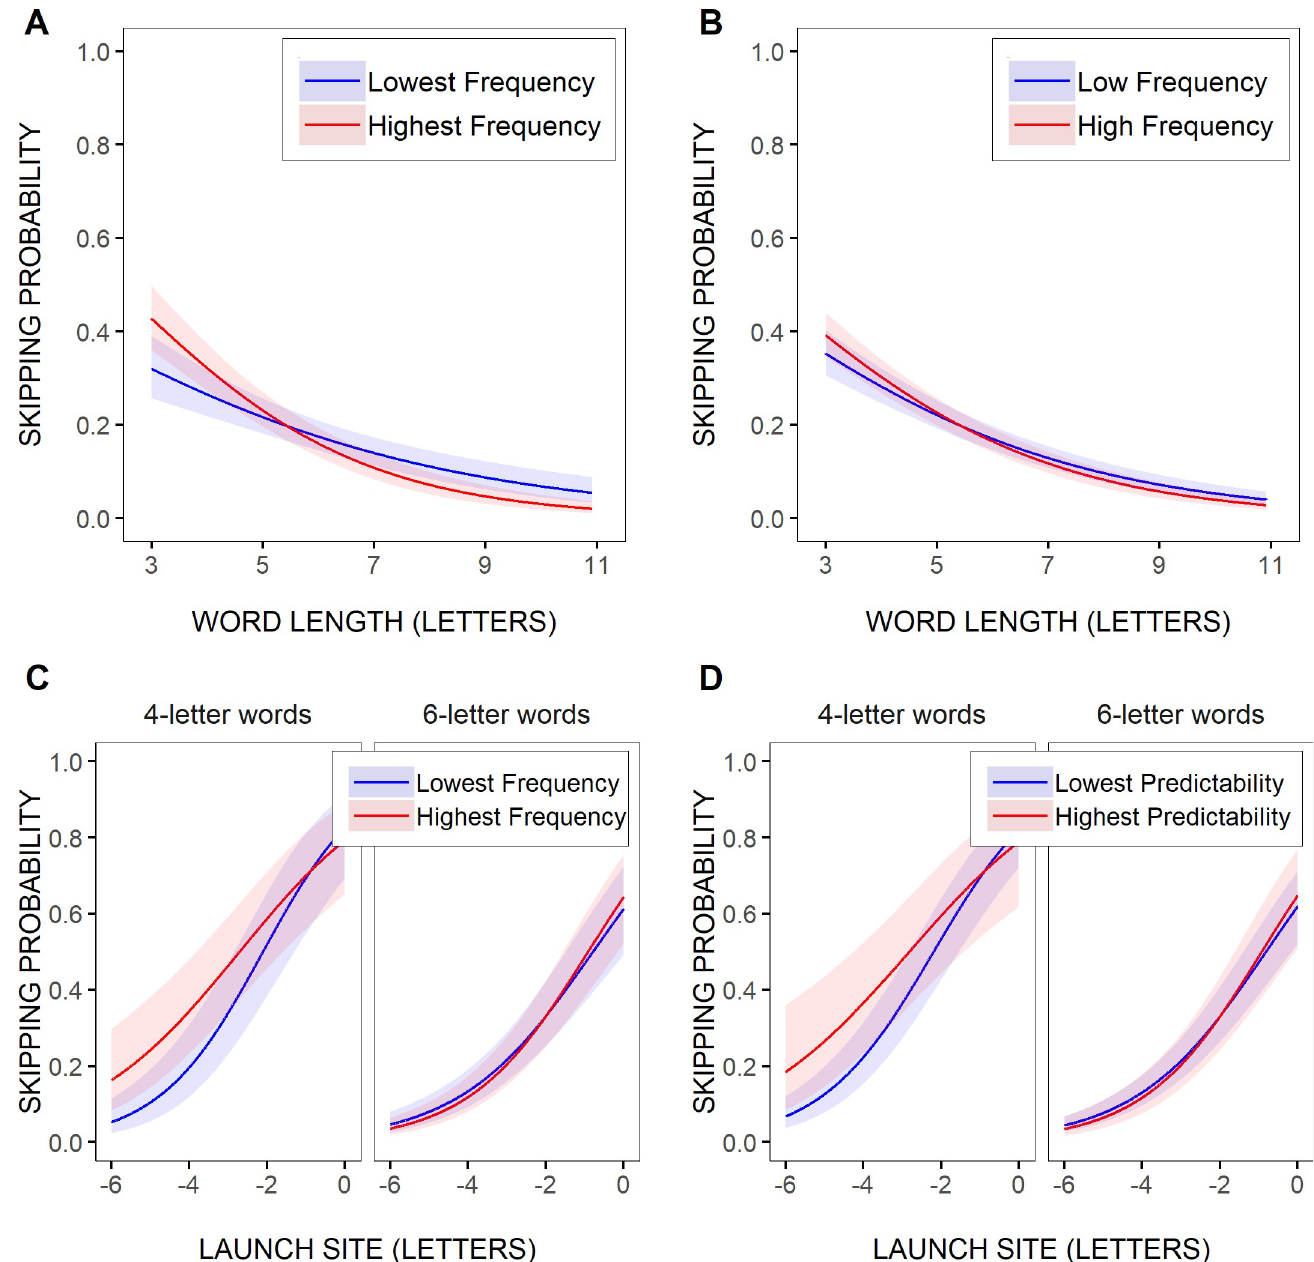
Fig 4. Estimated effects of visuo-motor and linguistic variables on test-word skipping rate. Partial effects (with 95% confidence intervals) computed from the parameters of GLMM Model 1 (A-B; Table 2) and GLMM Model 2 (C-D; Table 3), representing the estimated probability of skipping the test words as a function of word length (in letters; A-B), and for 4- and 6-letter test words as a function of saccadic launch-site distance (in letters relative to the space in front of the test words; C-D). In A,C, the models’ predictions were contrasted for the two most extreme (i.e., the lowest vs. the highest) word-frequency values across all selected test words regardless of their length and their predictability (0.20 and 5.93 log units respectively), and in D, they were contrasted for the two most extreme (i.e., the lowest vs. the highest) word-predictability values across all test words (-2.6 vs. 2.6 logit units). In B, Model 1’s predictions were represented for the mean frequency value of high vs. low-frequency words, as defined after grouping word frequencies into two bins (see Materials and Methods; 2.01 vs. 4.10 log units).